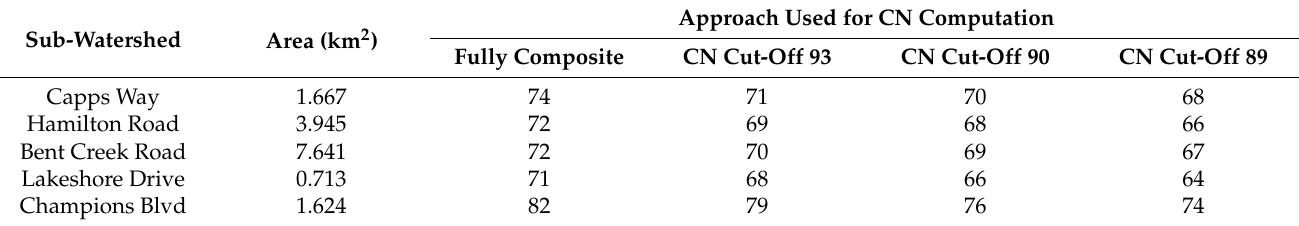
Table 4. Area-weighted average CN of each sub-watershed in this